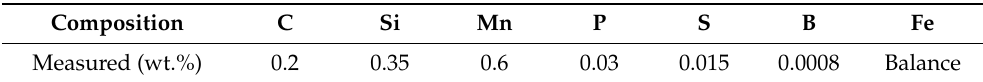
Table 2. The composition of SN400YB, used as the steel